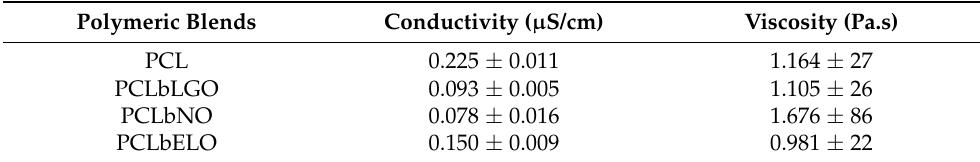
Table 3. Determination of conductivity and viscosity parameters associated with the